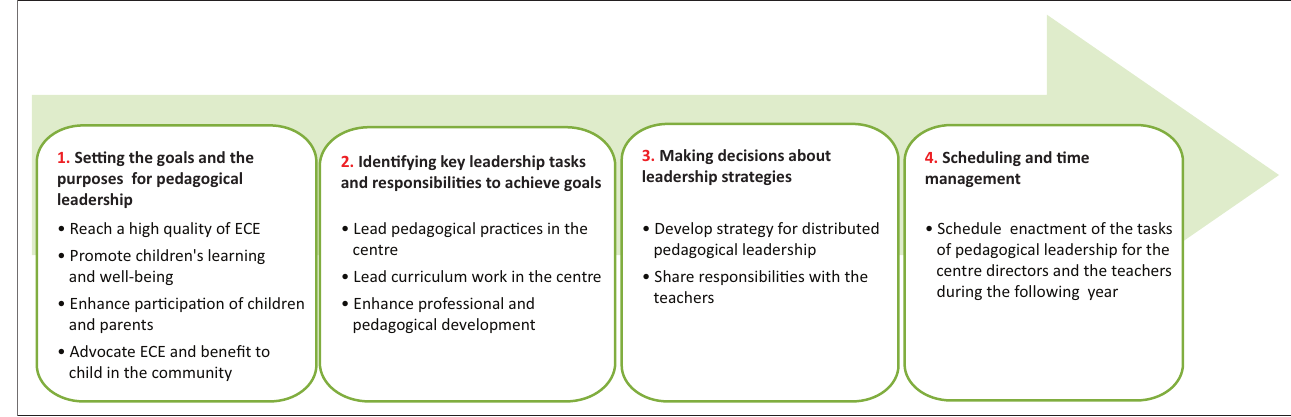
FIGURE 1: The contents and sequential progress of the pedagogical leadership action plans.